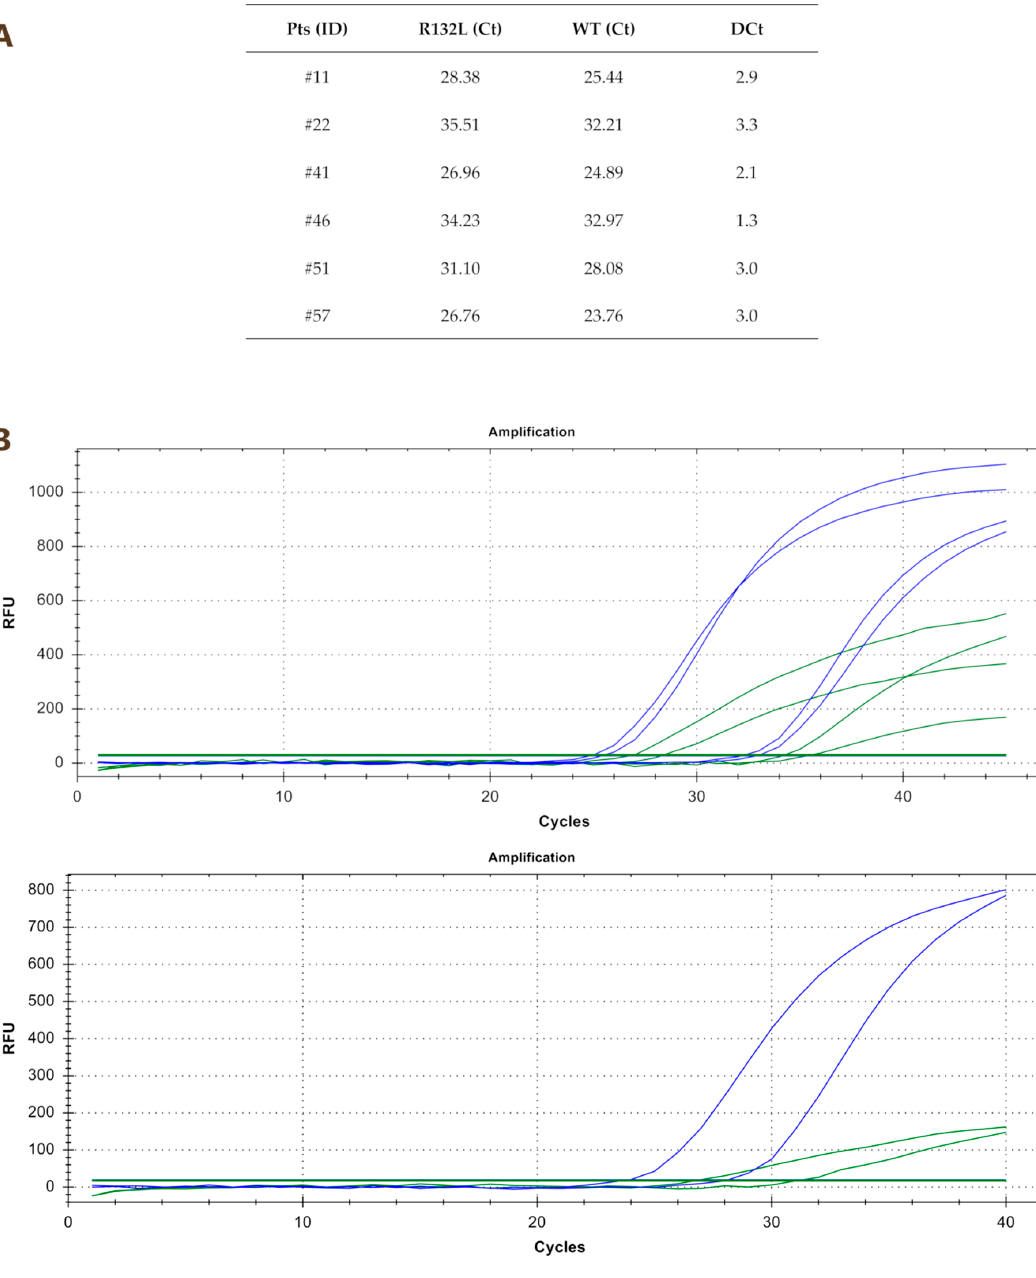
Figure 3. Ct values and amplification curves of qPCR of R132C (panel A ) and of R132G (panel B ) mutated samples. RFU indicates relative fluorescent units.